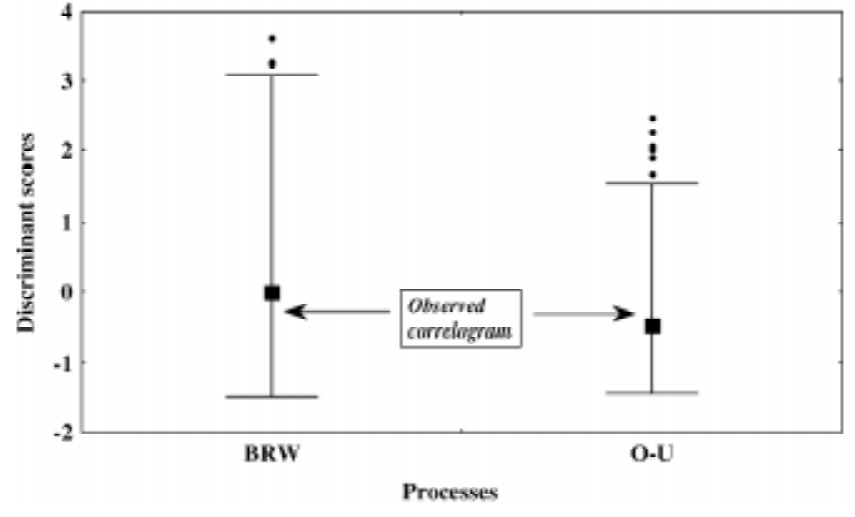
Figure 4 - Discriminant scores of the correlograms generated by simulations of Brownian motion (BRW) and O-U process of phenotypic evolution. The position of the score of the observed correlogram for the 19 species of South American owls is